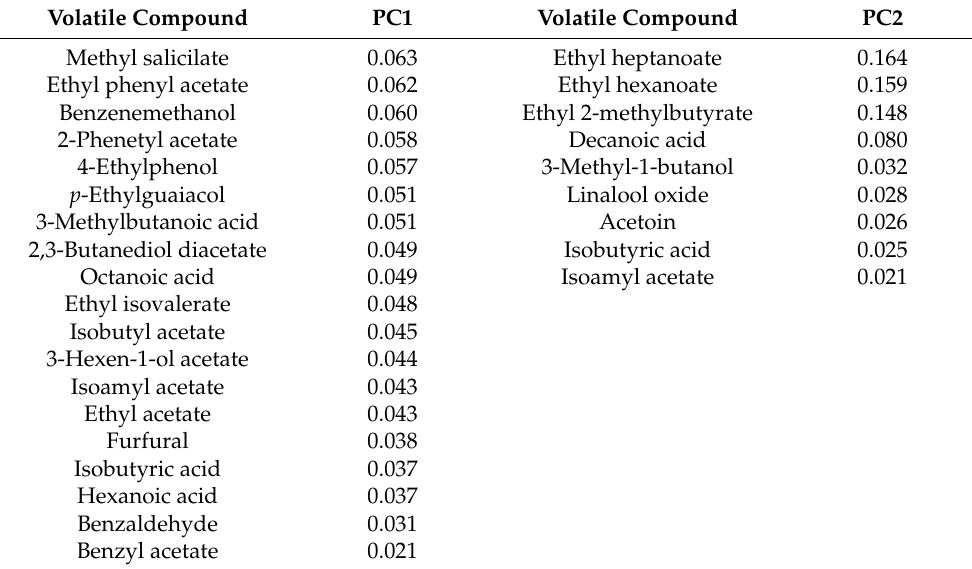
Table 6. Contribution of volatile compounds studied to the first two PC (values > 0.02).